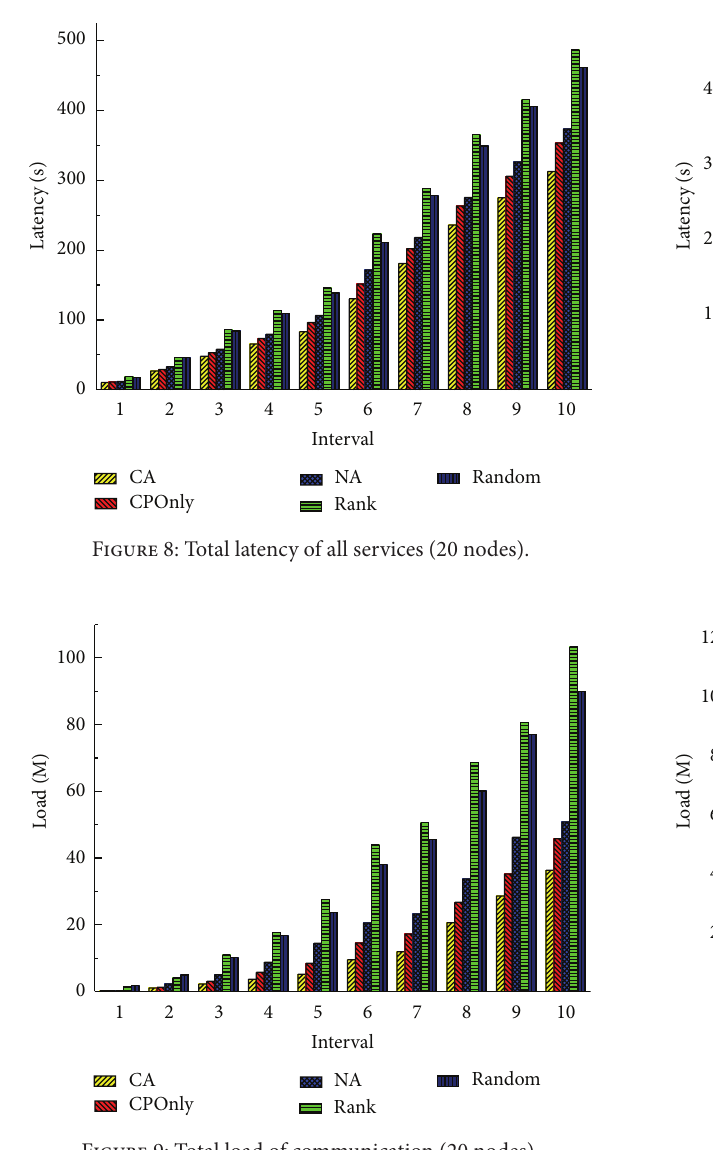
Figure 9: Total load of communication (20 nodes).